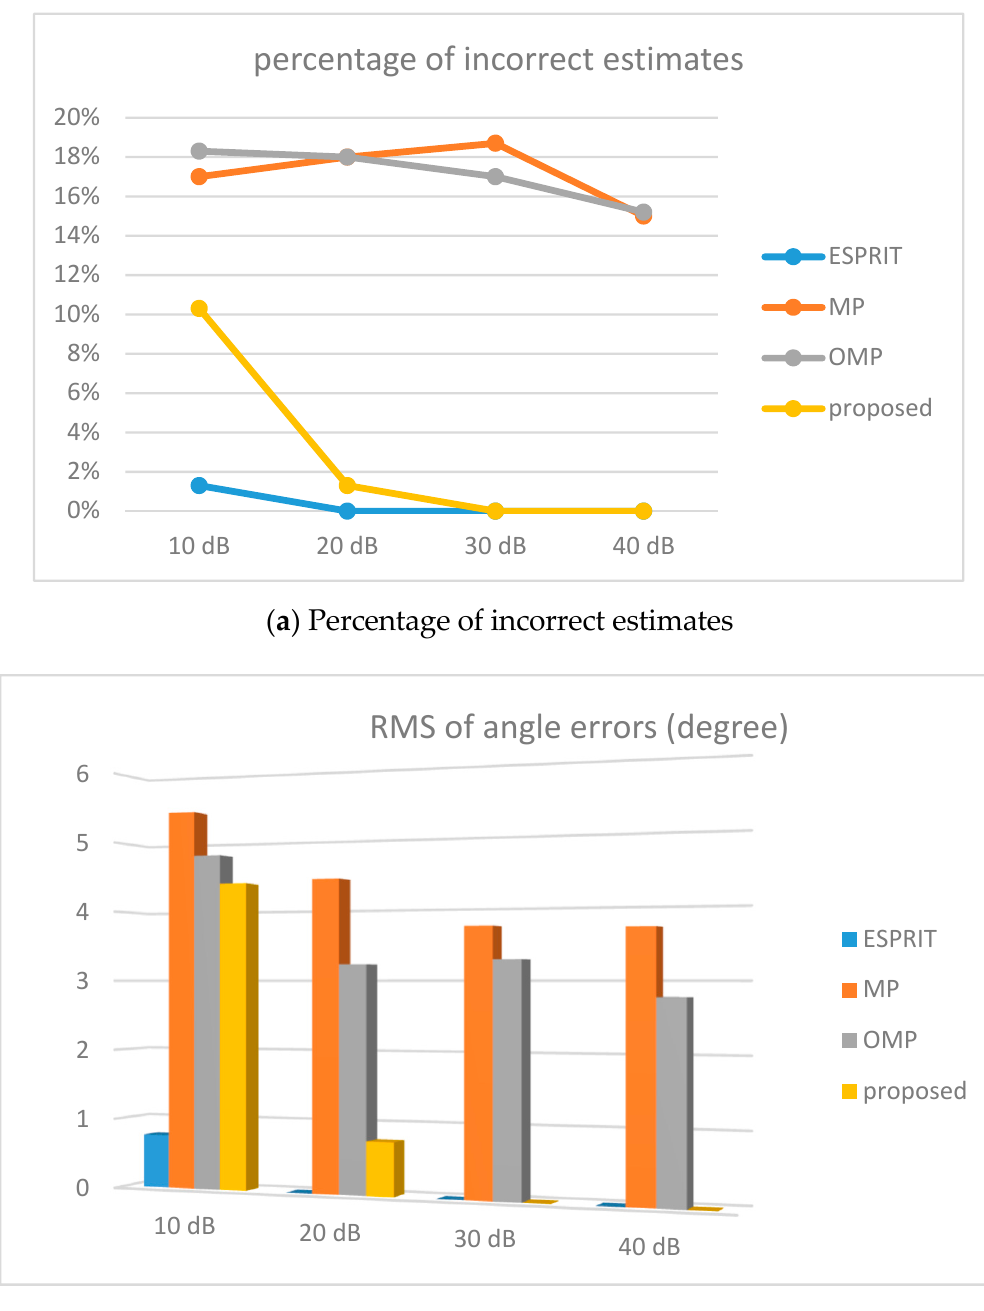
Figure 6. Estimation performance comparisons for K = 3 using codebook version 1 (M = 19 and 5 ◦